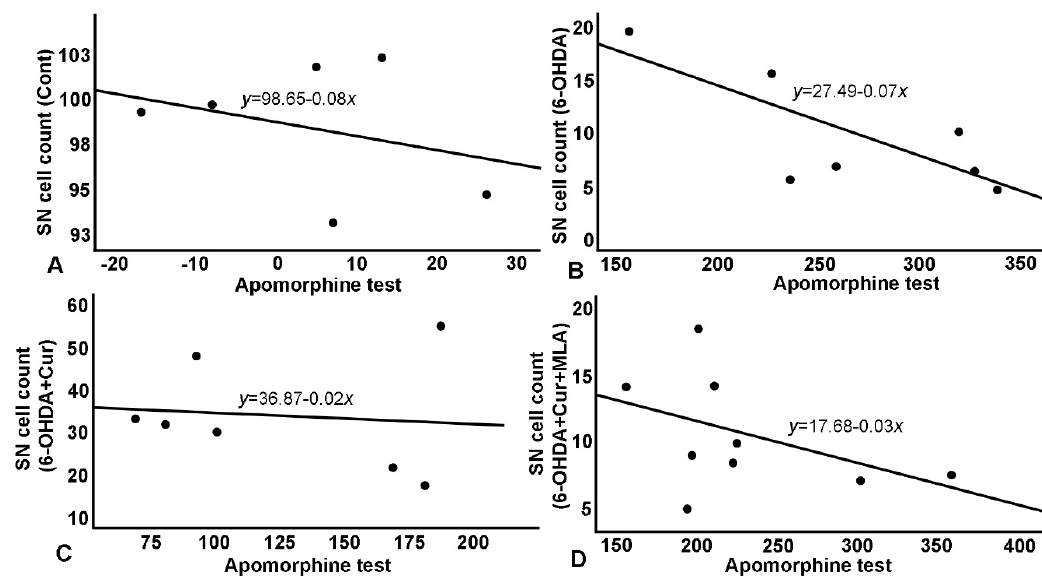
Figure 6. Relationship between apomorphine-induced rotation test and SN cell count. ( A ) A negative correlation in control group, with normal cell count (~100%) as reflected on number of rotation; ( B ) A negative correlation in 6-OHDA group with a steeper curve and a much-reduced number of surviving cells. 6-OHDA injected rats showed severe loss of TH+ve cells in the SN which affected rats’ performance in apomorphine test and in the shallower and less steep negative correlation; ( C ) Negative correlation in 6-OHDA+Cur group, where curcumin showed significant improvement in cells survival which was reflected significantly on apomorphine test; ( D ) Correlation in 6-OHDA+Cur+MLA group, MLA, an α 7-receptor blocker, reversed the protective effect of curcumin in 6-OHDA+Cur+MLA group, and consequently apomorphine test results were comparable to 6-OHDA injected group.